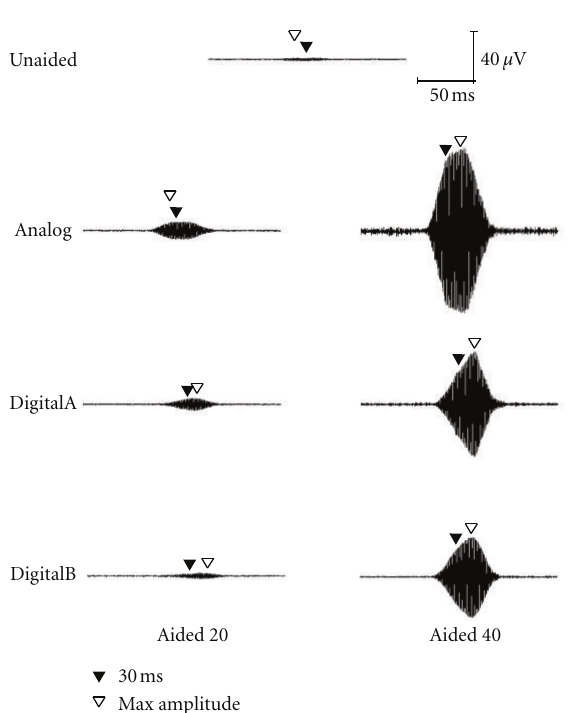
Figure 1: Waveform of the short stimulus presented at 30dB SPL as measured in the ear canal of a single representative subject (subject 2), where “Aided 20” indicates the 20-dB gain condition and “Aided 40” indicates the 40-dB gain condition. The closed triangle indicates the point 30ms after stimulus onset and the open triangle indicates the point at which maximum amplitude was reached.